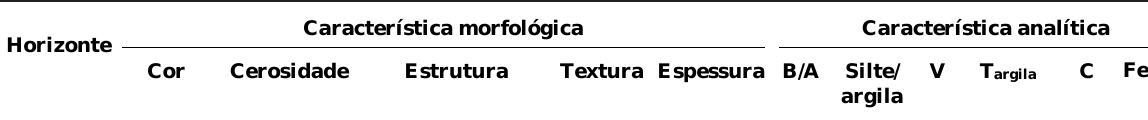
Quadro 1. Características morfológicas e analíticas dos perfis 1, 2 e 3